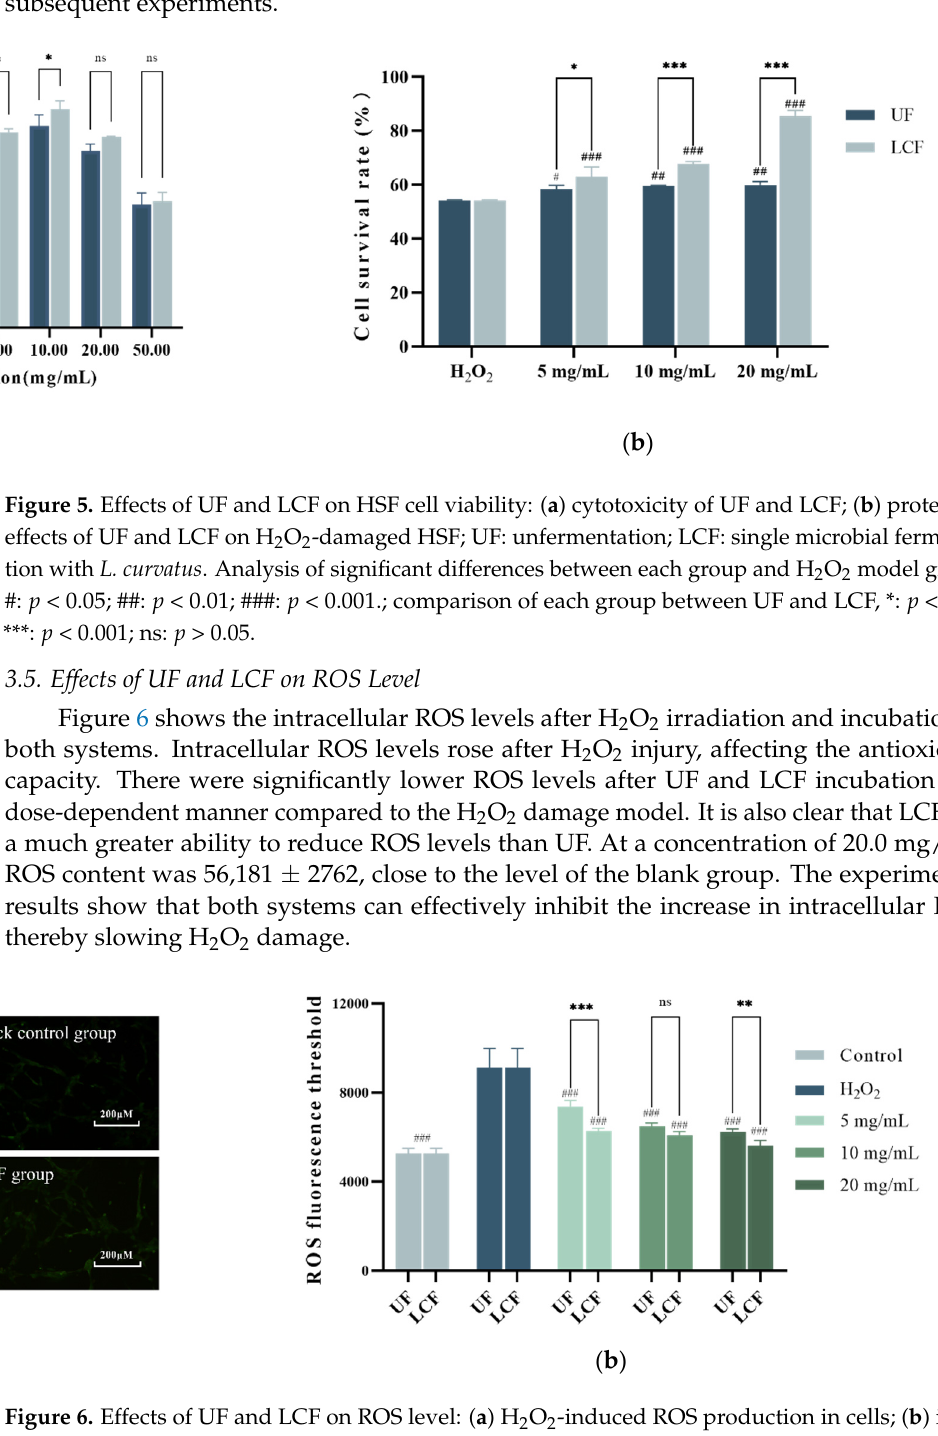
( b ) Figure 4. Phenolic components from samples of Euryale ferox show DPPH ( a ) and ABTS ( b ) scavenging properties. UF: unfermentation; LCF: single microbial fermentation with L. curvatus. 3.4. Effects of UF and LCF on HSF Cell Viability The effects of various drugs on cell viability can be determined by cytotoxicity assay. Figure 5a shows the toxicity of UF and LPF to cells. The results showed that the two